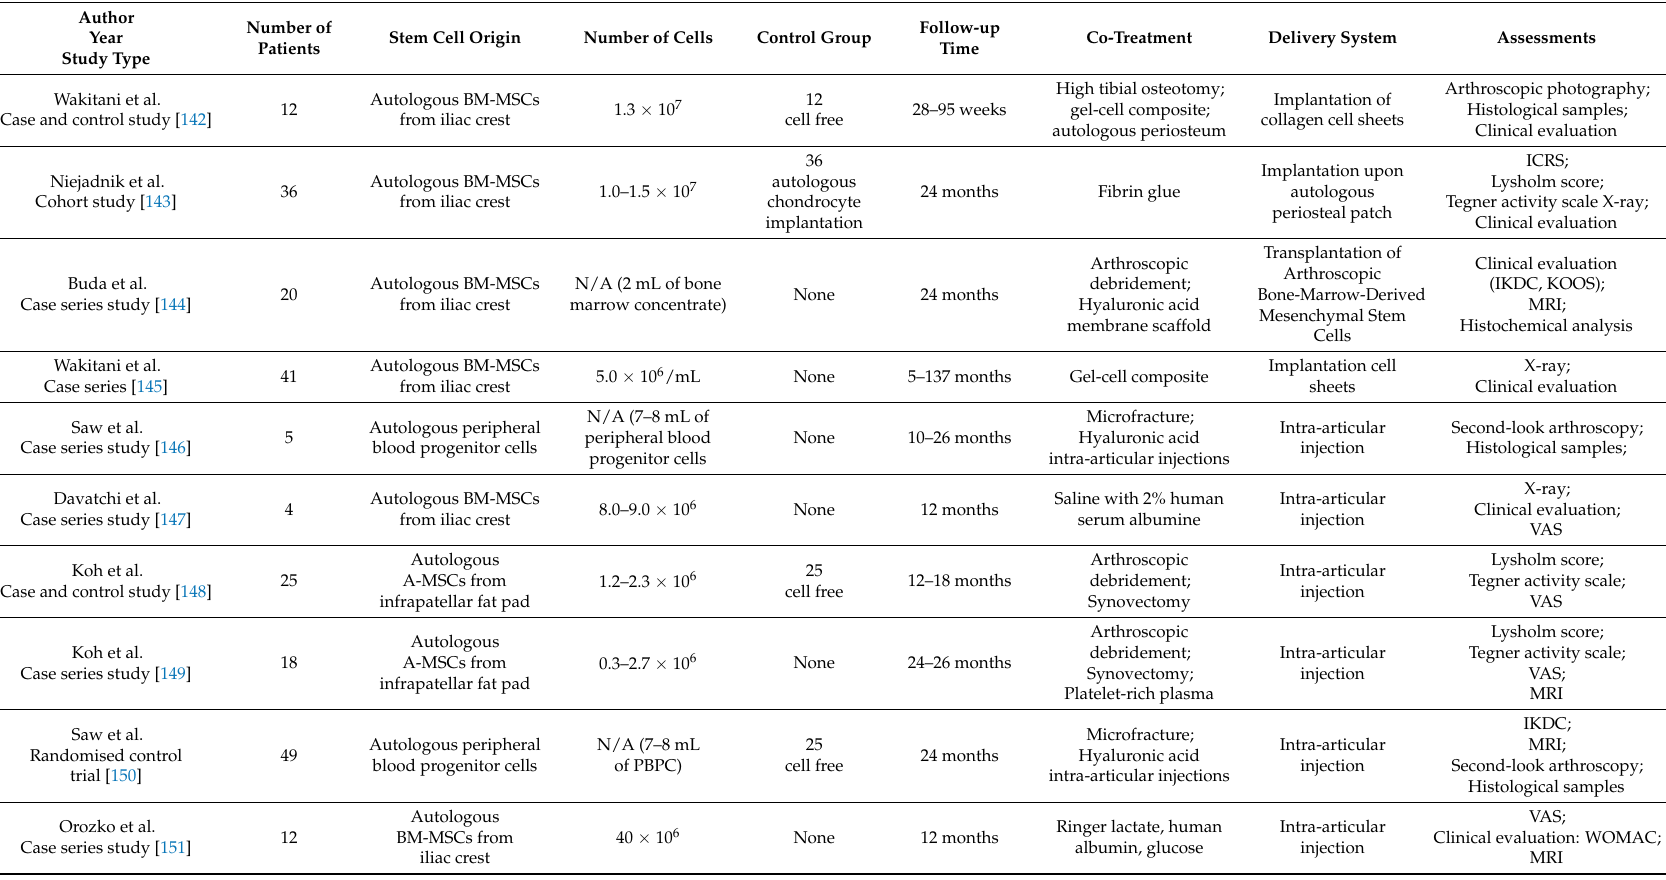
Table 1. List of publications of autologous mesenchymal stem cells application for cartilage